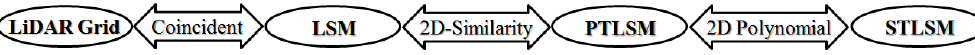
Figure 18. Mathematical relations among the 2D Transformed LiDAR shadow masks.